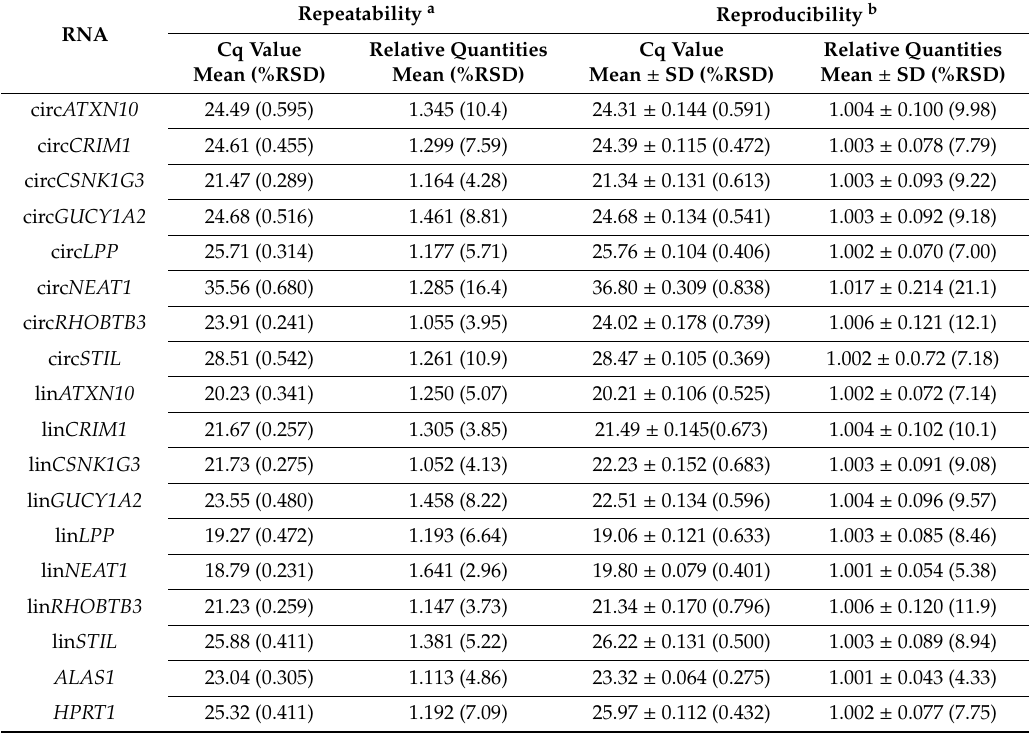
Table 3. Repeatability and reproducibility of RT-qPCR measurements.